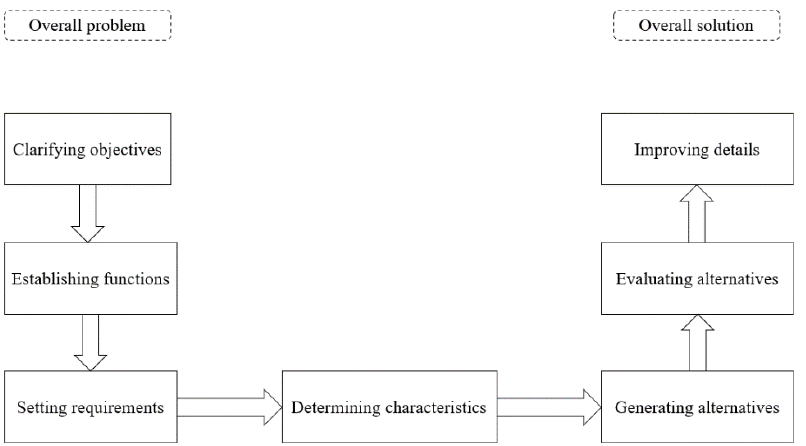
Figure 1. The seven stages of the design process, as proposed by Cross used to design the gasifier. Adapted from [12], with permission from publisher John Wiley and Sons, 2021.